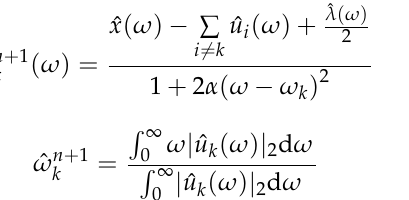
where X is the input data, W ei and β ei are the random weights matrix and the random bias matrix of mapping feature, respectively, Φ ( · ) is the nonlinear activation function, and Z i is the output